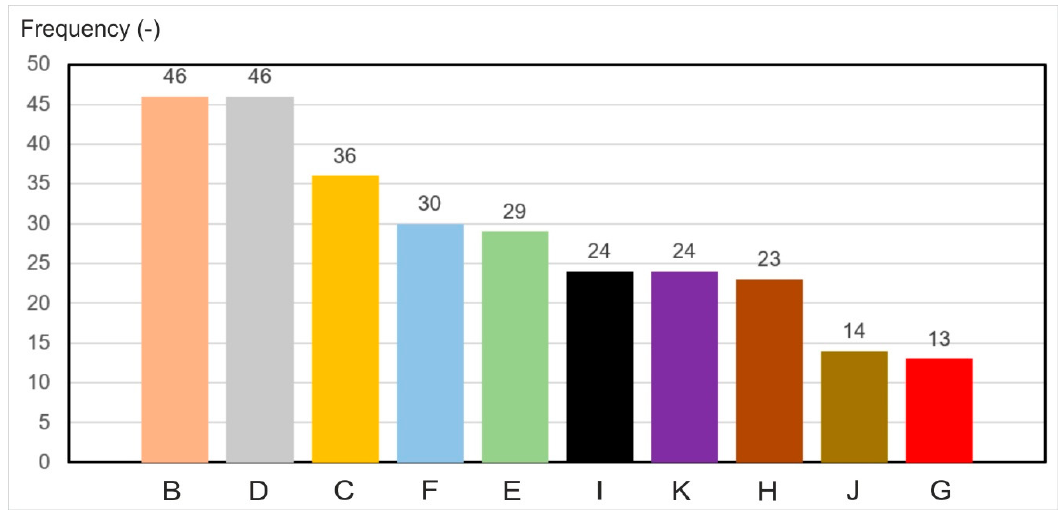
Figure 4. Frequency of individual PS ‐ OSs characteristics described in papers of our paper database— results of the second assignment process (paper groups are marked with the same letters as the paper groups listed above, see Table 1.).